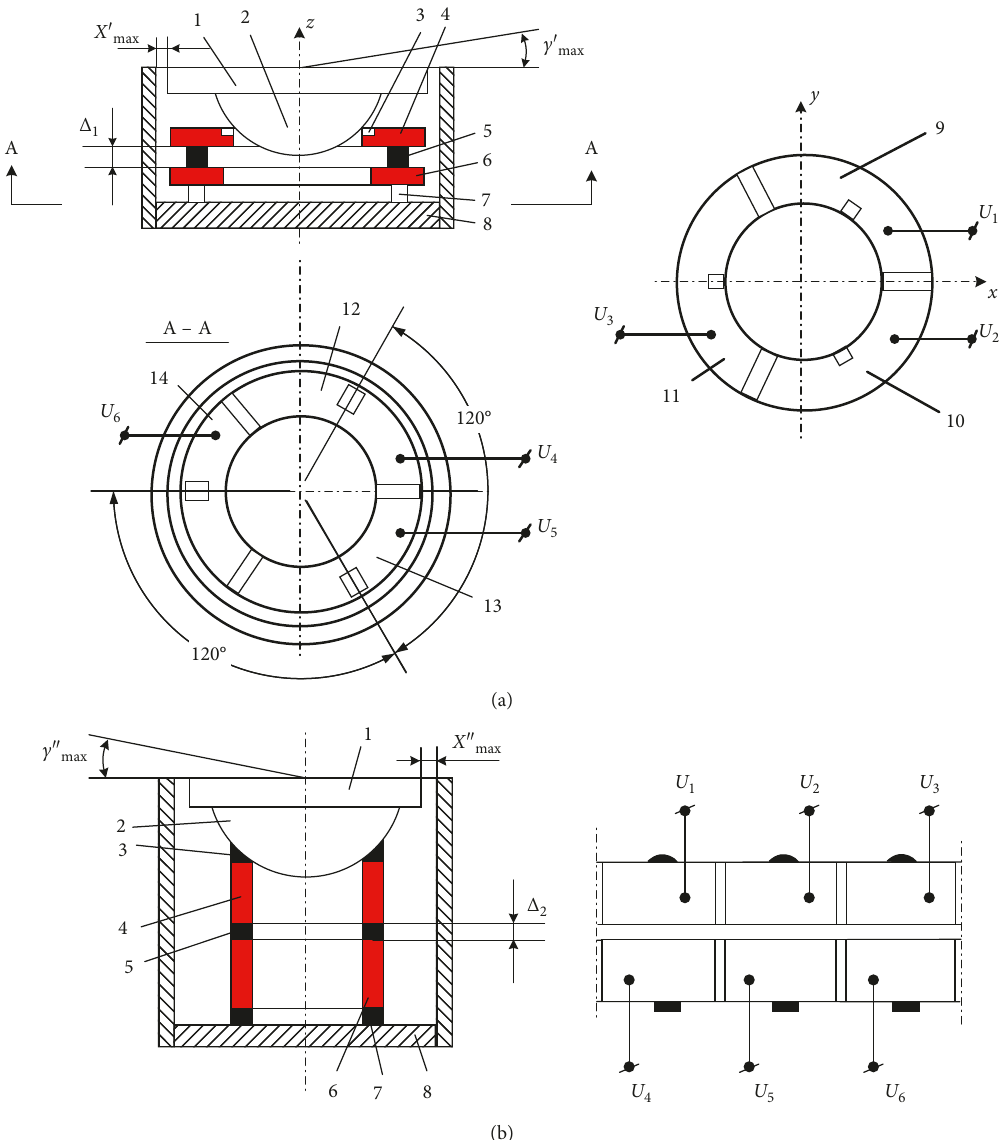
Figure 1: 6-DOF laser beam positioning actuator: ring type (a) and cylinder type